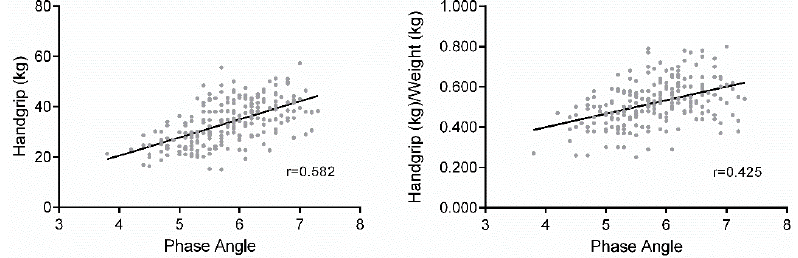
Figure 1. Partial correlation between muscle strength and phase angle in healthy men.